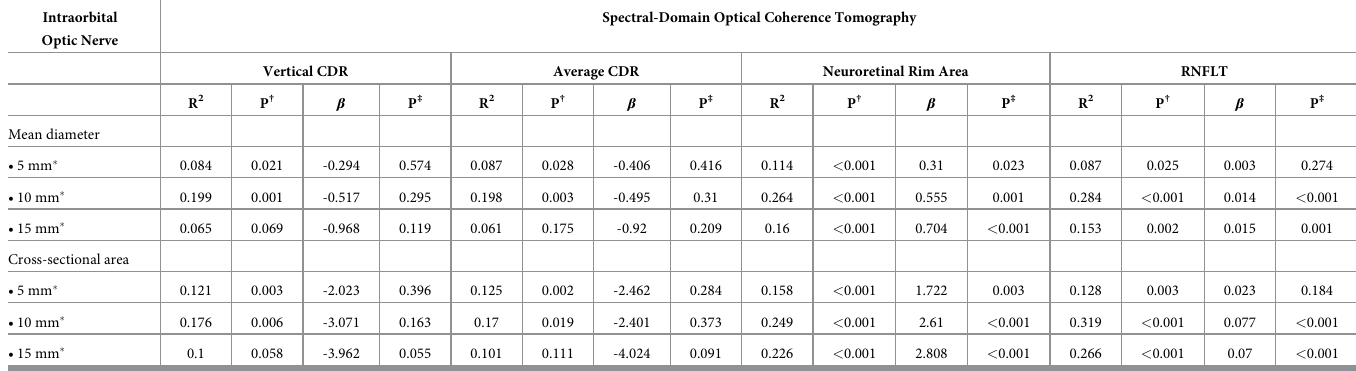
Table 5. Relationship between 3-Tesla magnetic resonance imaging findings of the intraorbital optic nerve and spectral-domain optical coherence tomography outcomes. Intraorbital OpticNerve